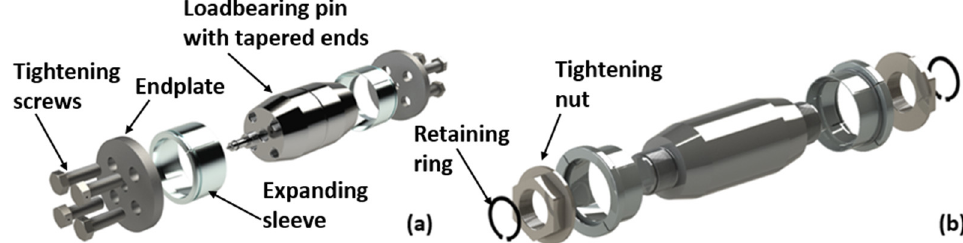
Figure 1. Expanding pin assembly ( a ) with tightening screws, and ( b ) with tightening